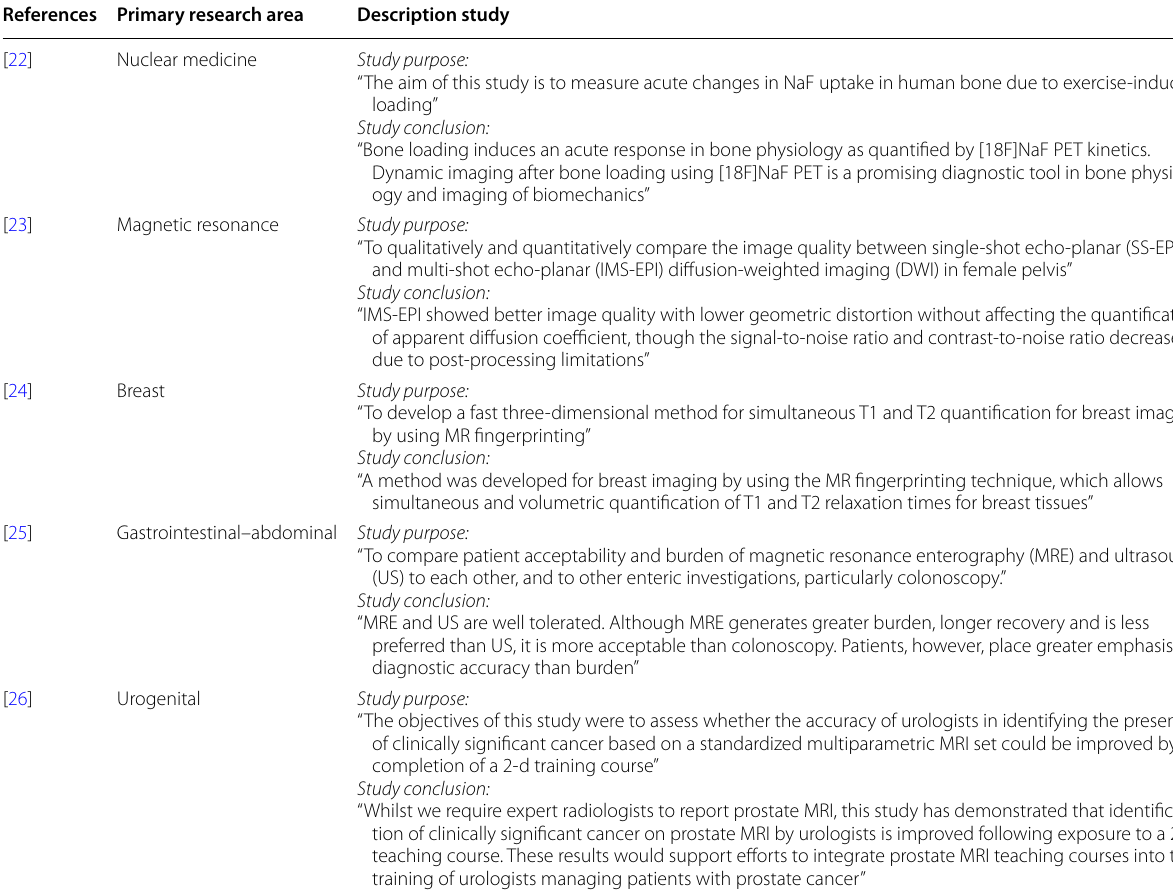
a Based on the applicability of the methods, results, interpretations, and conclusions, as described in each study, to the patient spectrum and radiology practice in the institutions of each of the two observers. Study quality was not a factor that influenced this decision b The examples shown in this table study could not directly contribute to patient care in the radiology practices of both observers 1 and